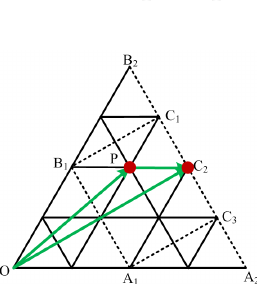
Figure 7. The method of determining the GVZ.